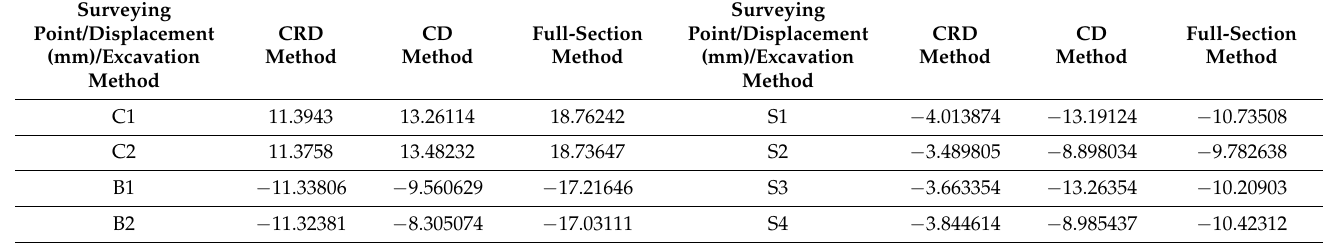
Figure 11. Effective plastic strain of secondary lining by the CRD method. Table 5. Deformation of secondary lining with different excavation methods.